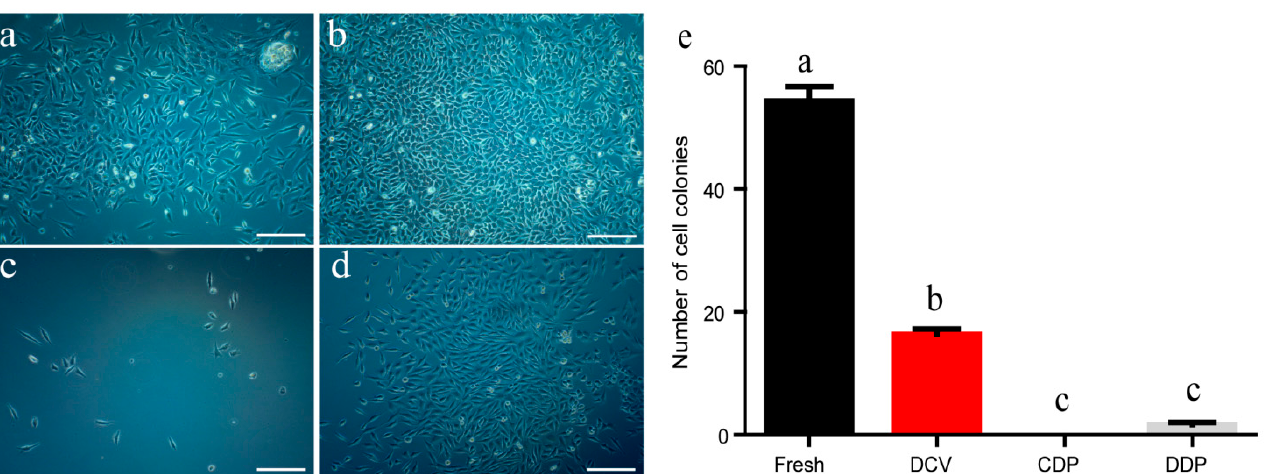
Figure 1. Effects of different vitrification methods on cell viability from thawed ear tissues. ( a ) Cells isolated from fresh tissue; ( b ) Cells isolated from tissues frozen by direct cover vitrification (DCV) method; ( c ) Cells isolated from tissues by cryovials directly plunged into LN2 (CDP) method; ( d ) Cells isolated from tissues by droplet directly plunged into LN2 (DDP) method; ( e ) Number of cell colonies with different vitrification methods. Error bars represent the SEM. Scale bar = 200 µ m.